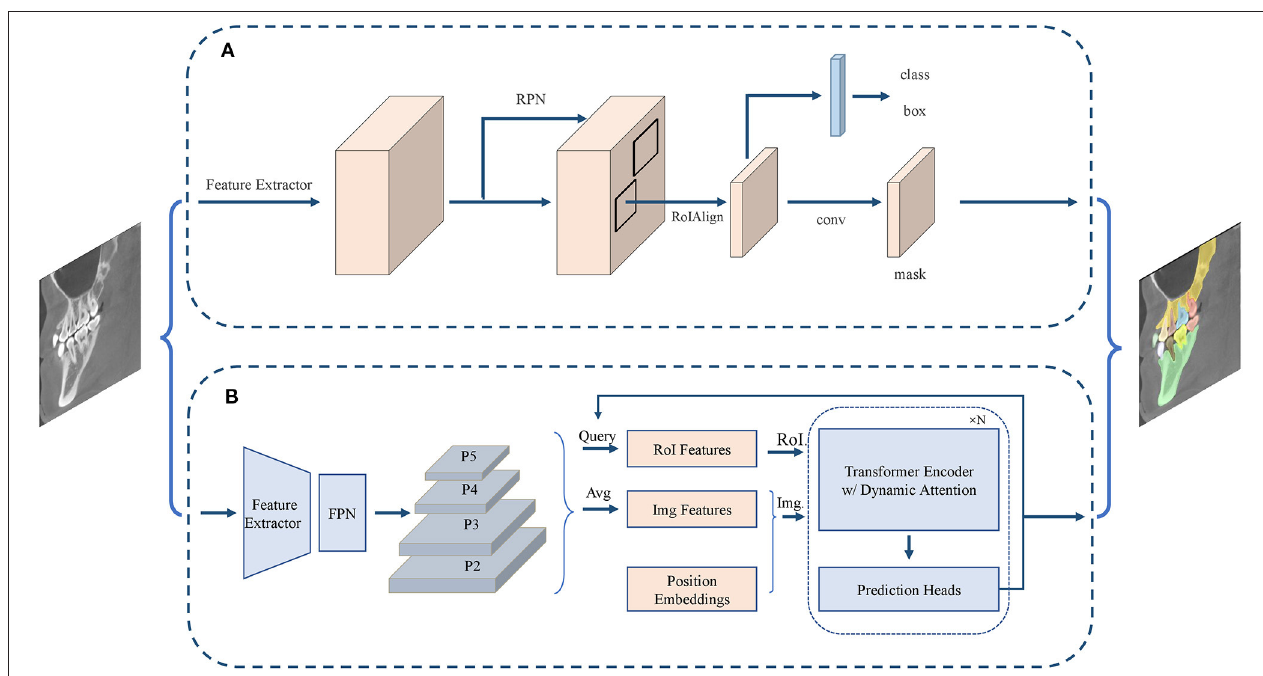
FIGURE 5 | Structure of instance segmentation network. (A) The CNN-based instance segmentation approach, from Mask R-CNN. (B) The Transformer-based instance segmentation approach, from